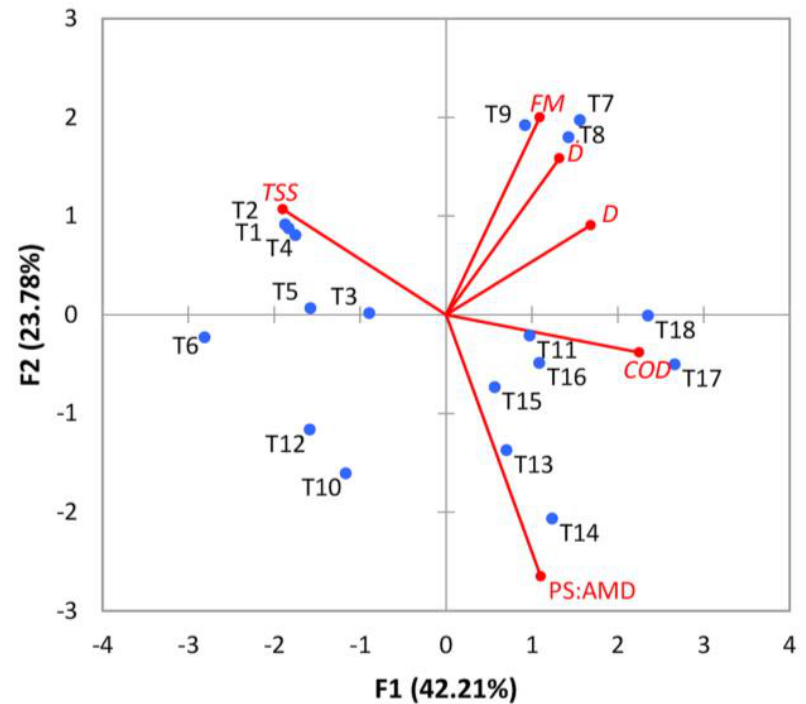
Figure 3. Factor scores in PCA Biplot (treatments T1…T18). Table 10 shows the factor scores for all tested treatments, pointing out their placement in the coordinate system made of the desired principal component. For example, in the case of F1 and F2, the factor score values in Table 10 are consistent with the PCA Biplot (Figure 3). Table 11 shows the squared cosines of the observations (T1 . . . T18) for output variables versus principal components. The excessive squared cosine suggests a proper representa- tion of the variable on the principal component as follows: F1 : T1, T2, T4 . . . T6, T12, T17, T18; F2 : T7 . . . T10, T13, T14; F3 : T11; F4 : T16; F5 : T3, T15. These results were further used for the treatment classification by AHC